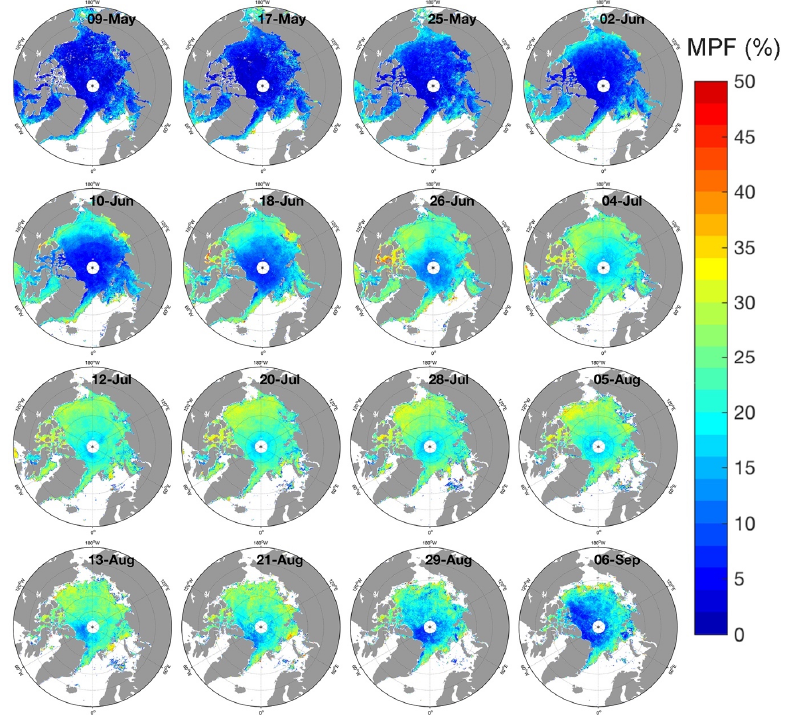
Figure 13. Same as Figure 12, except for the UH_MPFv2.